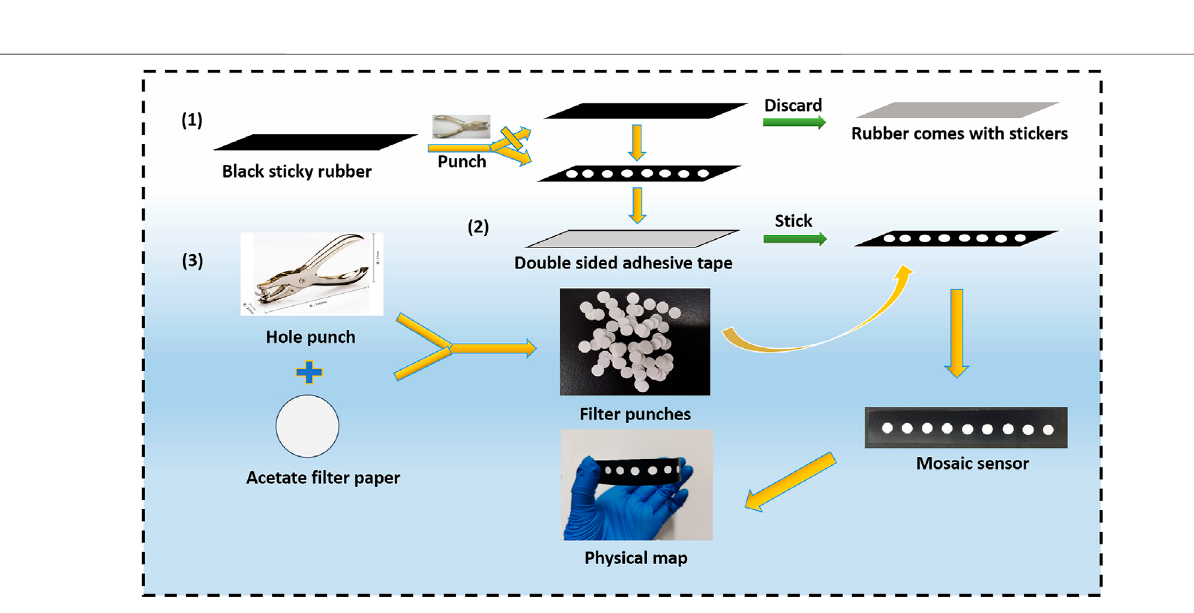
FIGURE 1 | Schematic diagram of the paper-based sensor